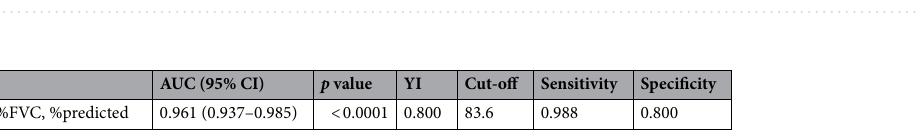
Table 6. ROC curve analysis of %FVC to predict PRISm among community-dwelling older people. AUC Area under the curve, CI Confidence interval, FVC Forced vital capacity, PRISm Preserved ratio impaired spirometry, ROC Receiver operating characteristic, YI Youden’s index (Sensitivity + Specificity −